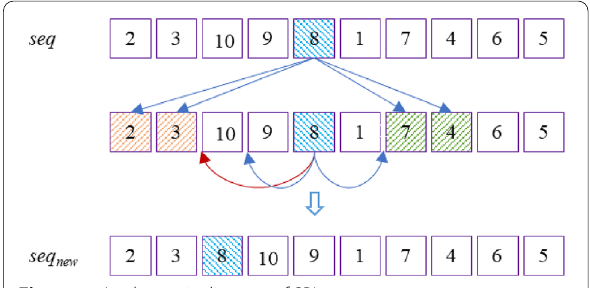
Figure 5 A schematic diagram of